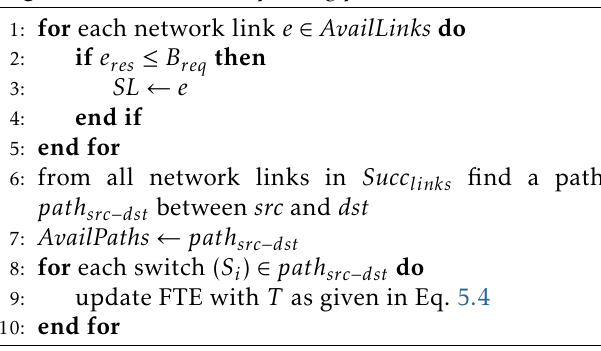
Algorithm 3 - SAND: Updating phase